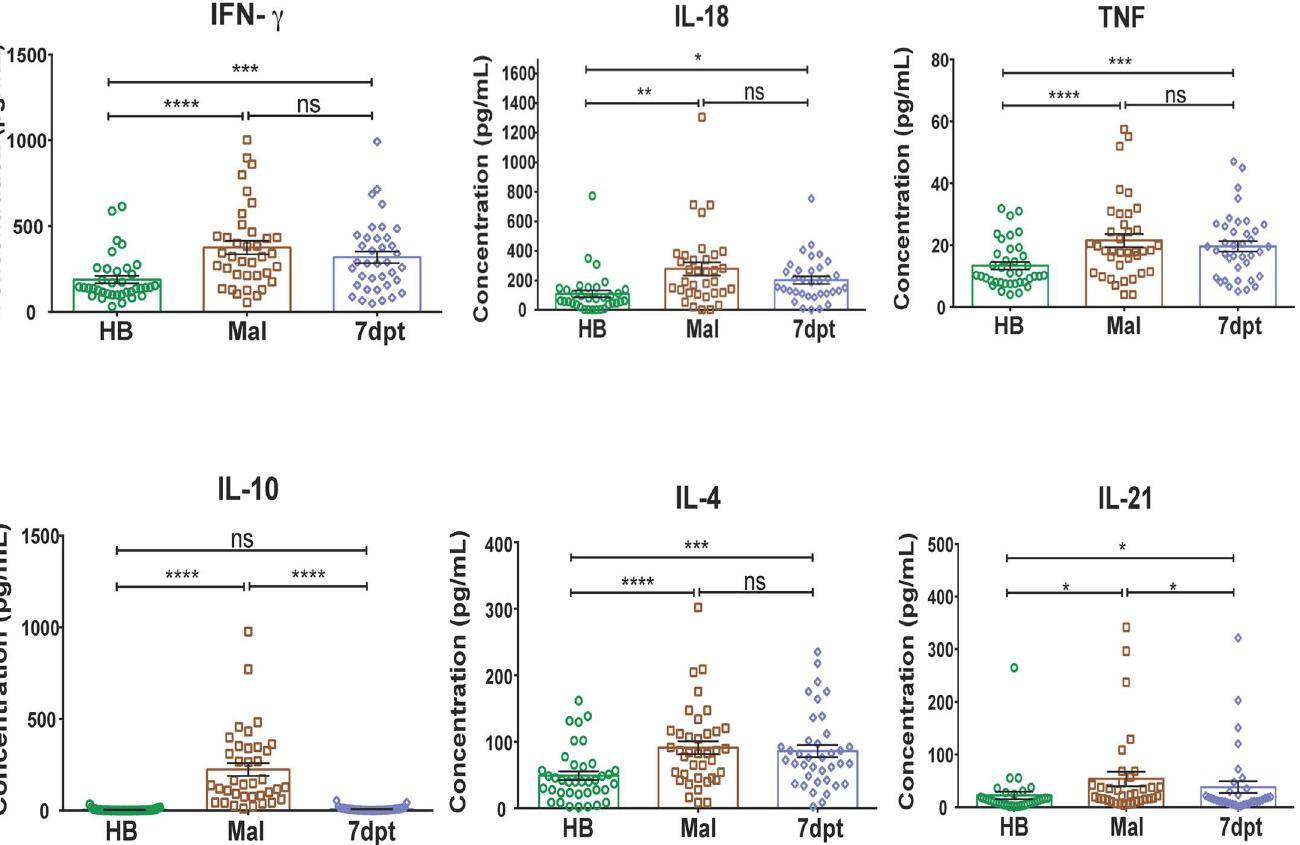
Fig 8. Plasmacytokine response in children during acute malaria. Plasma cytokine levels in Malianchildren(n = 37) at their healthybaseline(HB), during acute febrile malaria (Mal) and 7 days after anti-malarial treatment (7dpt). The Th2 cytokines IL-5 and IL-13 were not detectableat any time point. p values were determinedby ANOVA with Sidak corrections where appropriate. **** P < 0.0001, *** P < 0.001, ** P < 0.01, * P < 0.05,ns = not